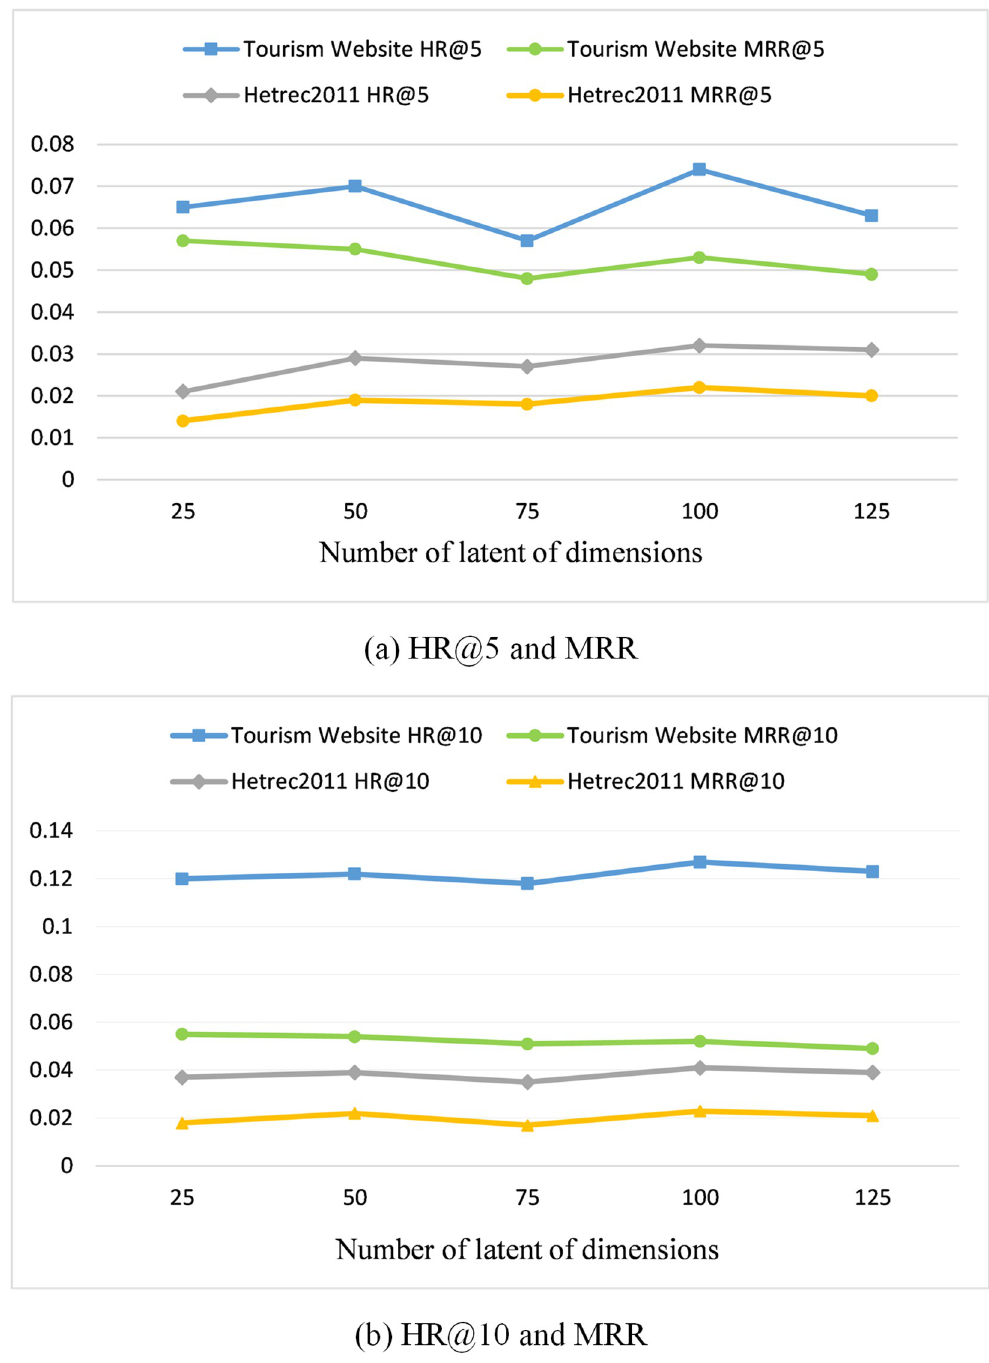
Fig 6. Effects of number of latent dimensions d